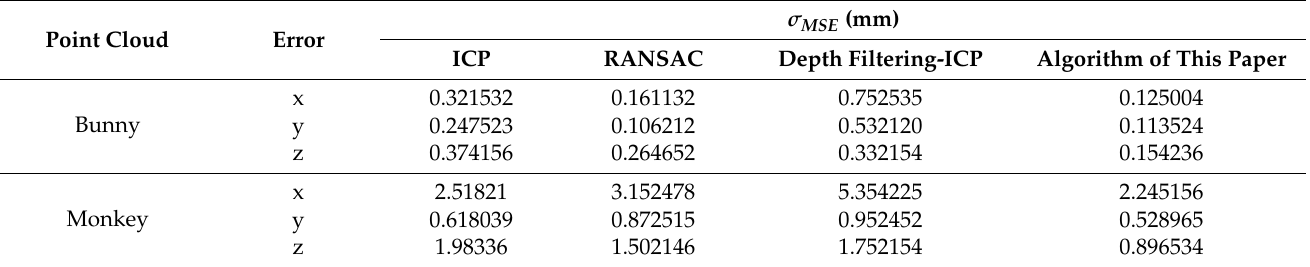
Table 2. Comparison of mean square error between the proposed algorithm and other